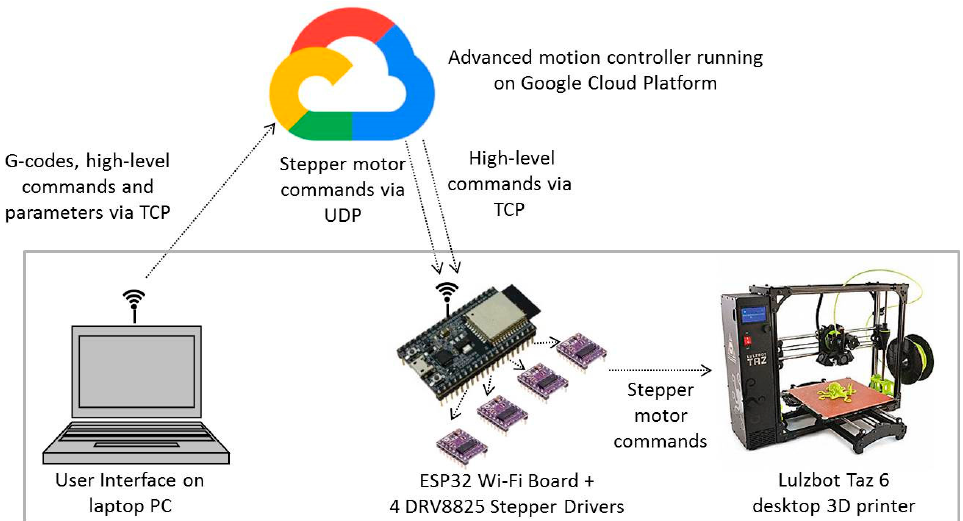
Figure 2. Overview of setup for experiments.